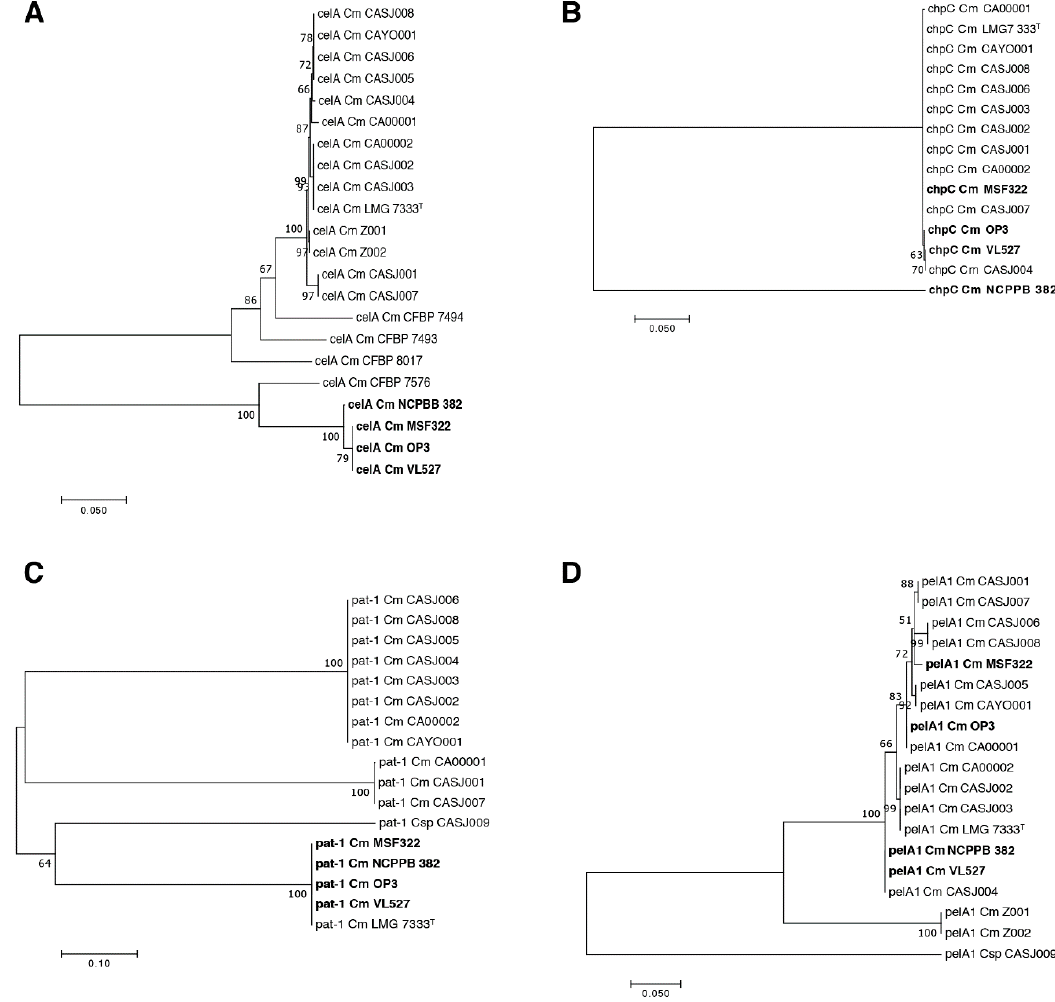
Figure 6. Phylogenetic analysis of celA , chpC , pat-1 and pelA1 genes. Phylogenetic relationships of celA ( A ), pat-1 ( C ) and pelA1 ( D ) genes were inferred by the maximum likelihood method, based on the Tamura 3-parameter. The rate variation model allowed for some sites to be evolutionarily invariable (39.8% sites). The analysis involved 20 nucleotide sequences. There was a total of 1302 nucleotide positions in the final dataset. Analysis of the chpC gene ( B ) was inferred by the maximum likelihood method, based on the Kimura 2-parameter model. Methods were proposed by Akaike information criterion for selection of appropriate evolutionary model using MEGA version 7. The trees are drawn to scale, with branch lengths measured in the number of substitutions per site.